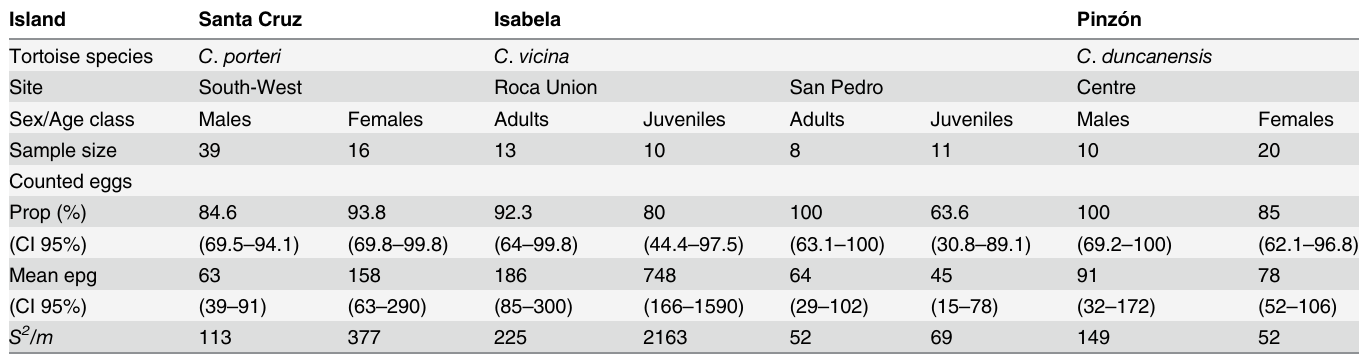
Table 3. Description of nematode egg distributions according to sex or age class within four wild populations of Galápagos giant tortoise.